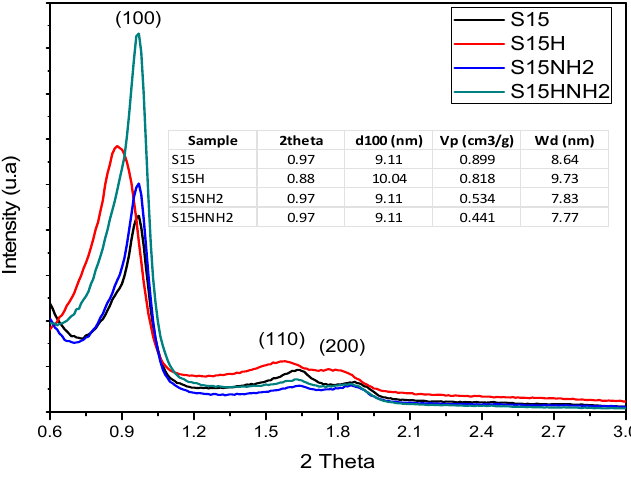
Figure 6. Low angle X-ray Diffraction (XRD) diffractograms of S15, S15H, S15NH 2 , and S15HNH 2 solids.